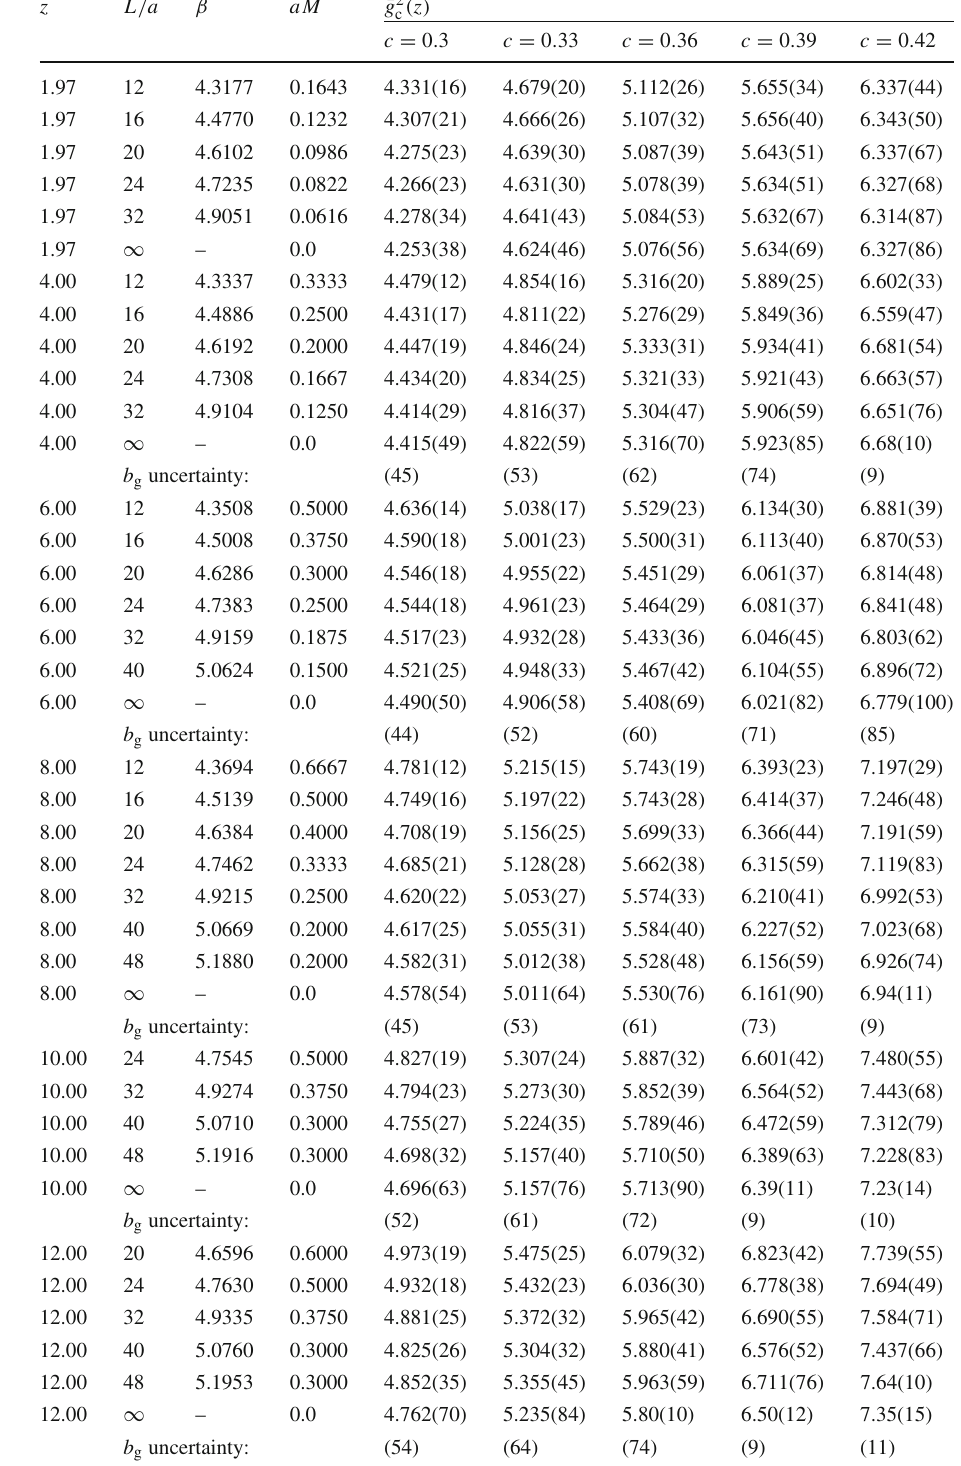
Table 2 Values of the massive coupling ¯ g 2 c ( z ) and its continuum extrapolated values. The results quoted for the continuum extrapolations correspond to a global fit of the data with z ≥ 4 and ( aM ) 2 ≤ 0 . 16 and